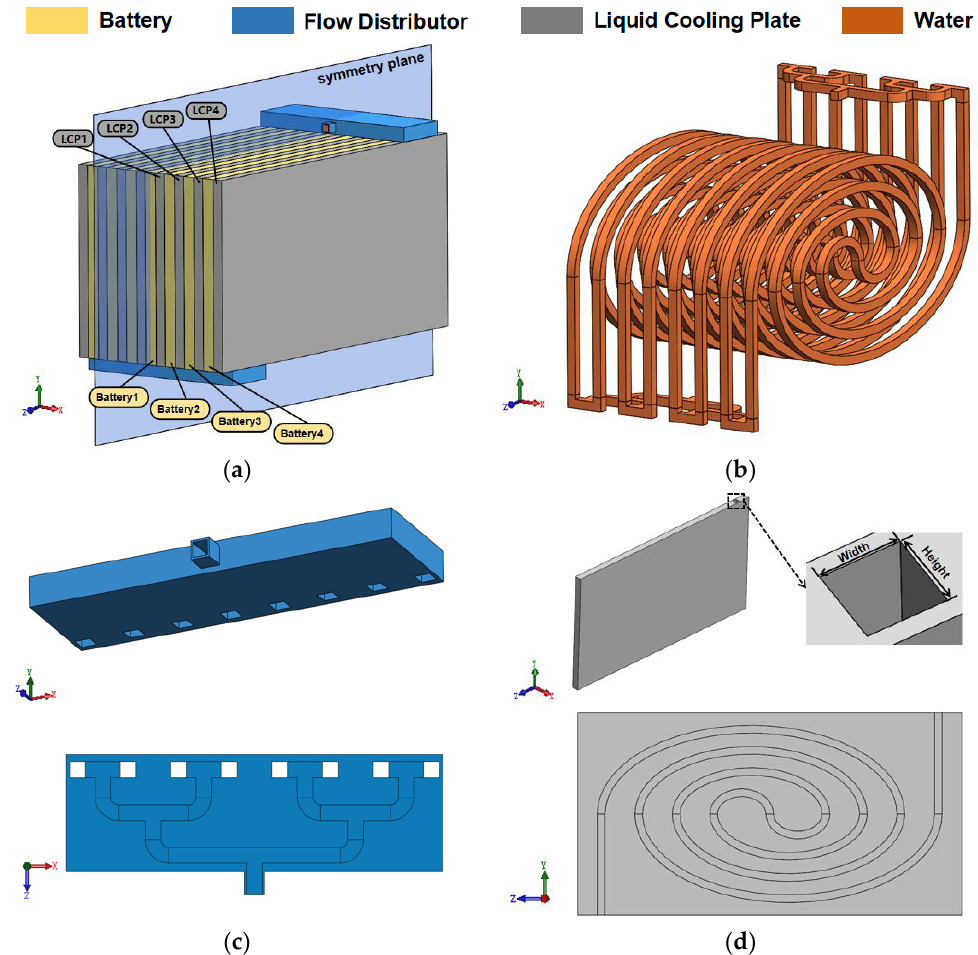
Figure 1. Design of liquid cooling BTMS. ( a ) Battery module liquid cooling system structure; ( b ) the flow path of coolant; ( c ) structure of the flow distributor; ( d ) structure of the LCP.